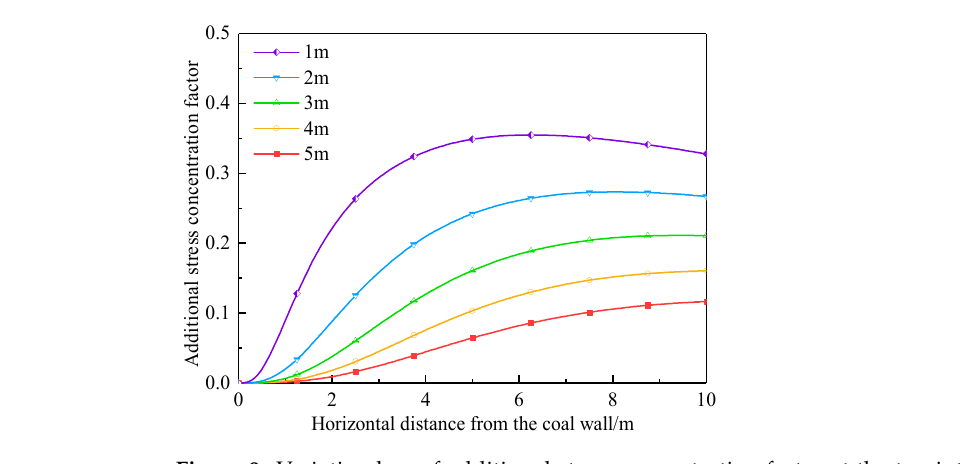
Figure 9. Variation law of additional stress concentration factor at the top interface of coal pillar under different conditions.